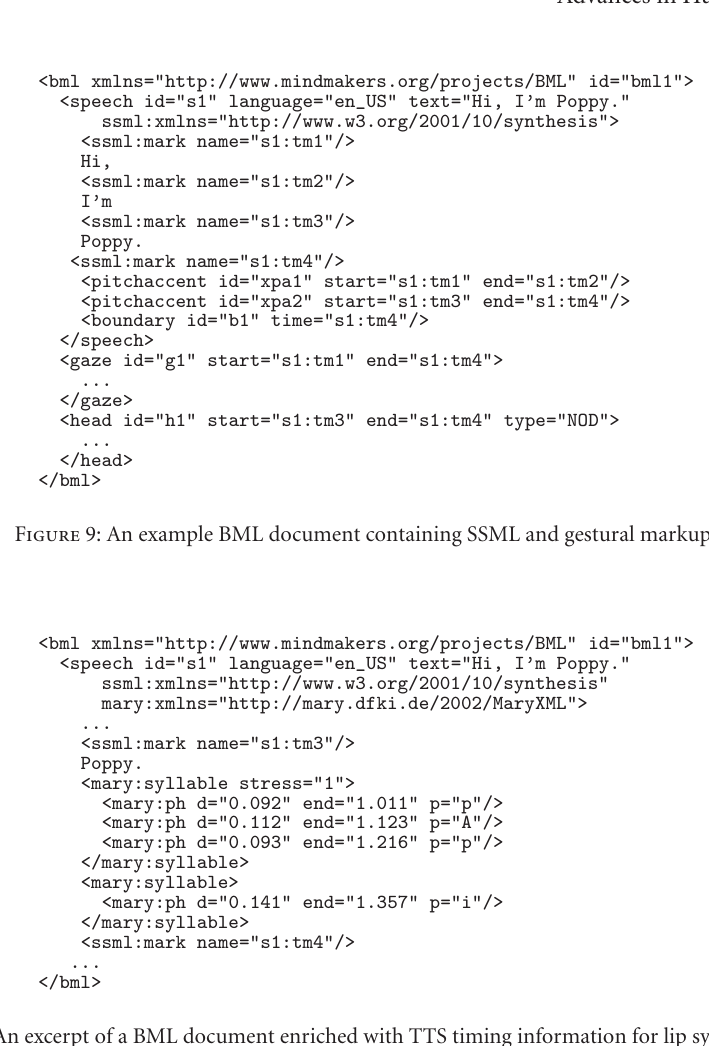
Figure 10: An excerpt of a BML document enriched with TTS timing information for lip synchronisation.